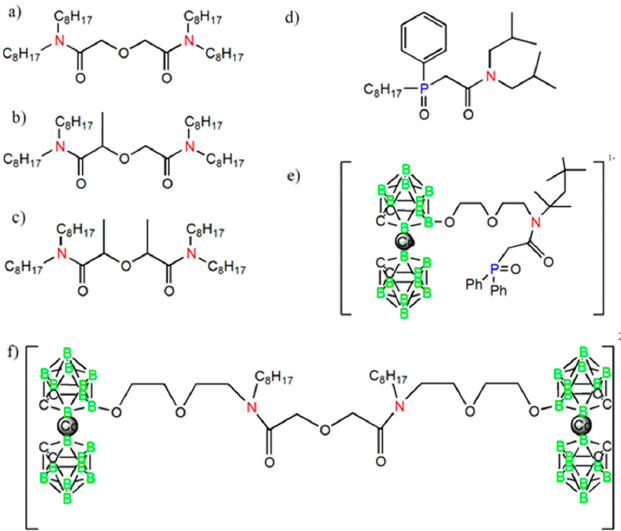
Figure 1. Ligand structures: ( a ) N,N,N’,N’ -tetraoctyldiamide of diglycolic acid (TODGA); ( b ) methylated TODGA (Me-TODGA); ( c ) dimethylated TODGA (2Me-TODGA); ( d ) octylphenyl- N,N -di-isobutylcarbamoylmethylen phoshine oxide (CMPO); ( e ) CMPO-cobalt bis(dicarbollides) (CD-CMPO); ( f ) TODGA-di-cobalt bis(dicarbollides) (CD-DGA). Polymeric sensor membranes were prepared according to the standard procedure [8]. Corresponding quantities of membrane components were weighted, transferred to a glass beaker, and dissolved in freshly distilled tetrahydrofuran under mixing for 20 min. After the complete